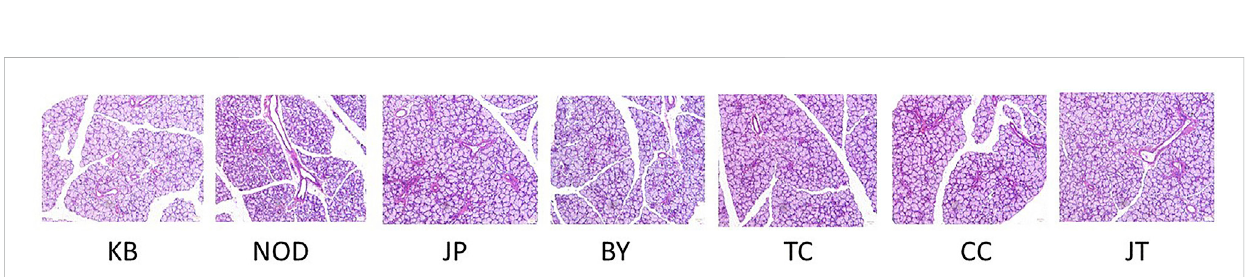
FIGURE 7 Pathological section of submandibular gland (100×). Letters in the fi gure indicates the group name; From left to right, control; NOD model; Tangeretin; Chrysin; Sinensetin; 5-demethylnobiletin; Extract administration.